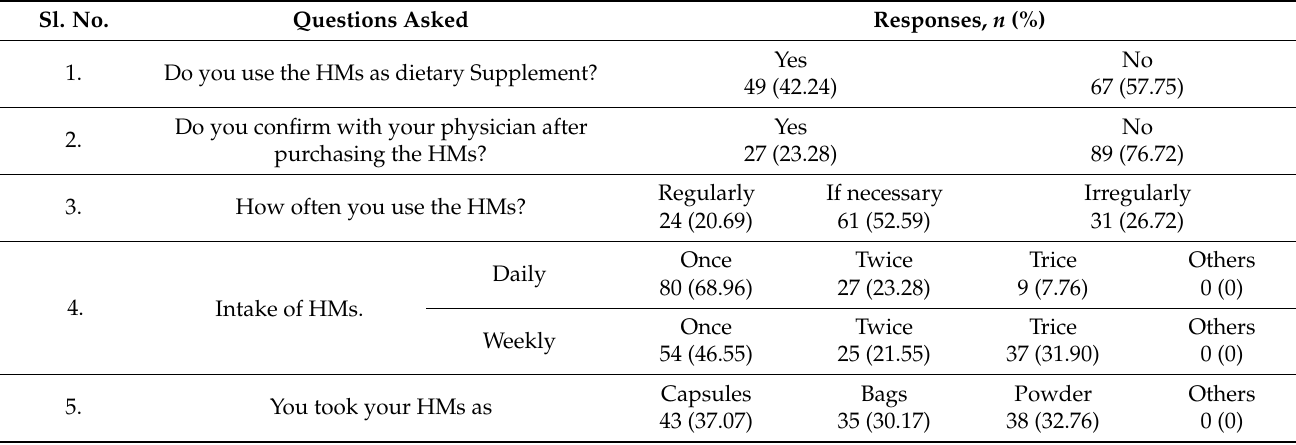
Table 4. Use of HMs by respondents ( n = 116 out of